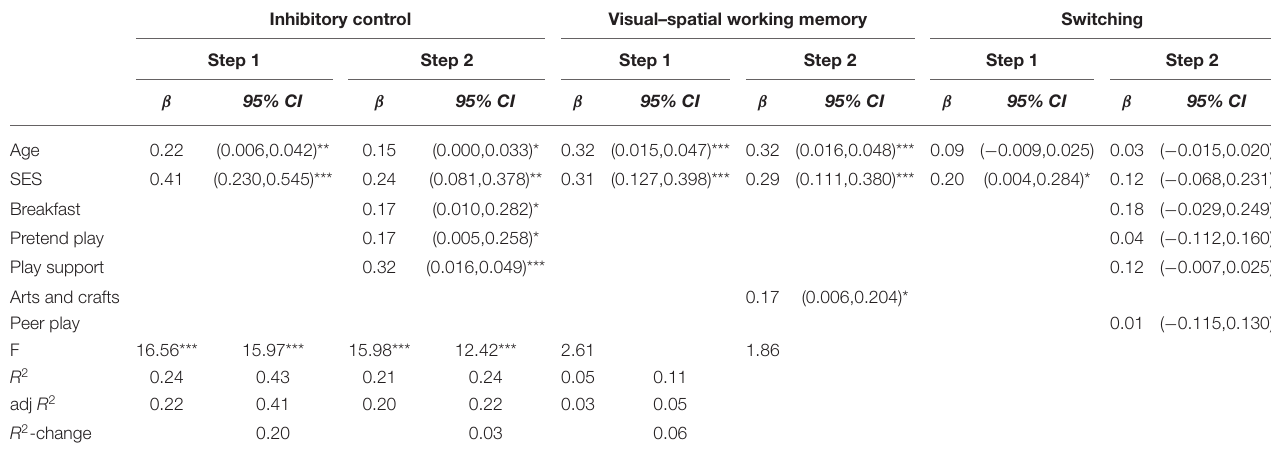
TABLE 7 | Summary of hierarchical multiple regression models predicting executive function skills in Ethiopian sample. Inhibitory control Visual–spatial working memory